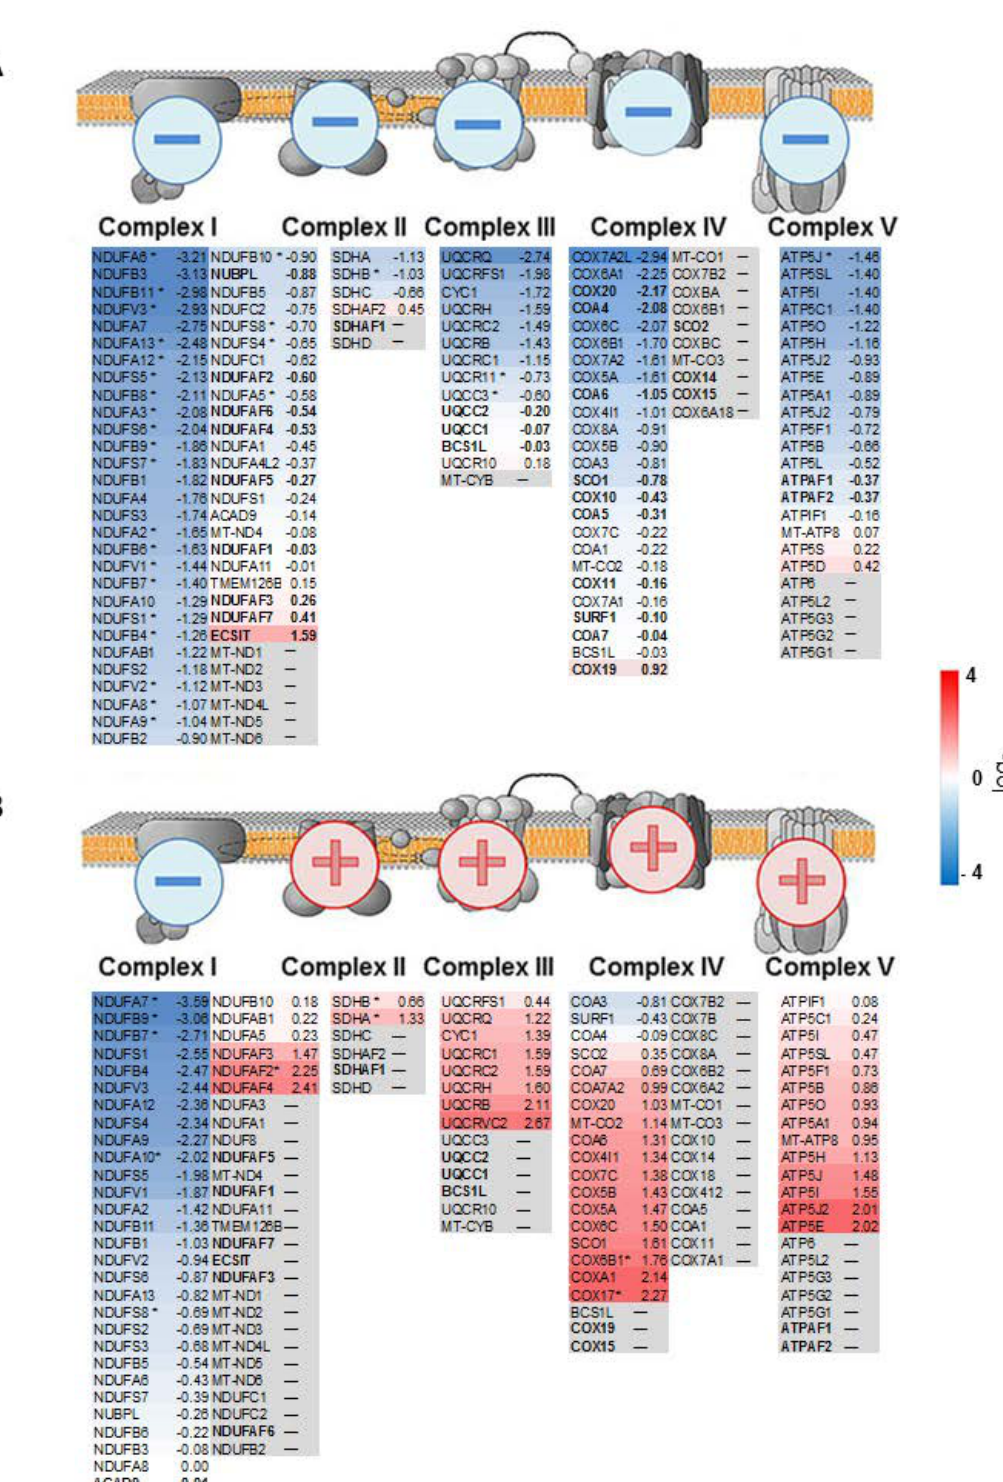
Figure 3. Protein abundance ratios for all individual complexes of the respiratory chain, shown for ( A ) papillary renal cell carcinoma (pRCC) type I and ( B ) renal oncocytomas. Illustrated are schemes of the four OXPHOS complexes and the F 0 F 1 ATPase, including subunits and assembly factors and the according log 2 fold change between pRCC or renal oncocytomas versus kidney samples. The color gradient intensity in the subunit expresses the low (blue) or high (red) abundance of this protein in the tumor. Assembly factors, not part of the final complexes are shown in bold. * indicates significantly regulated